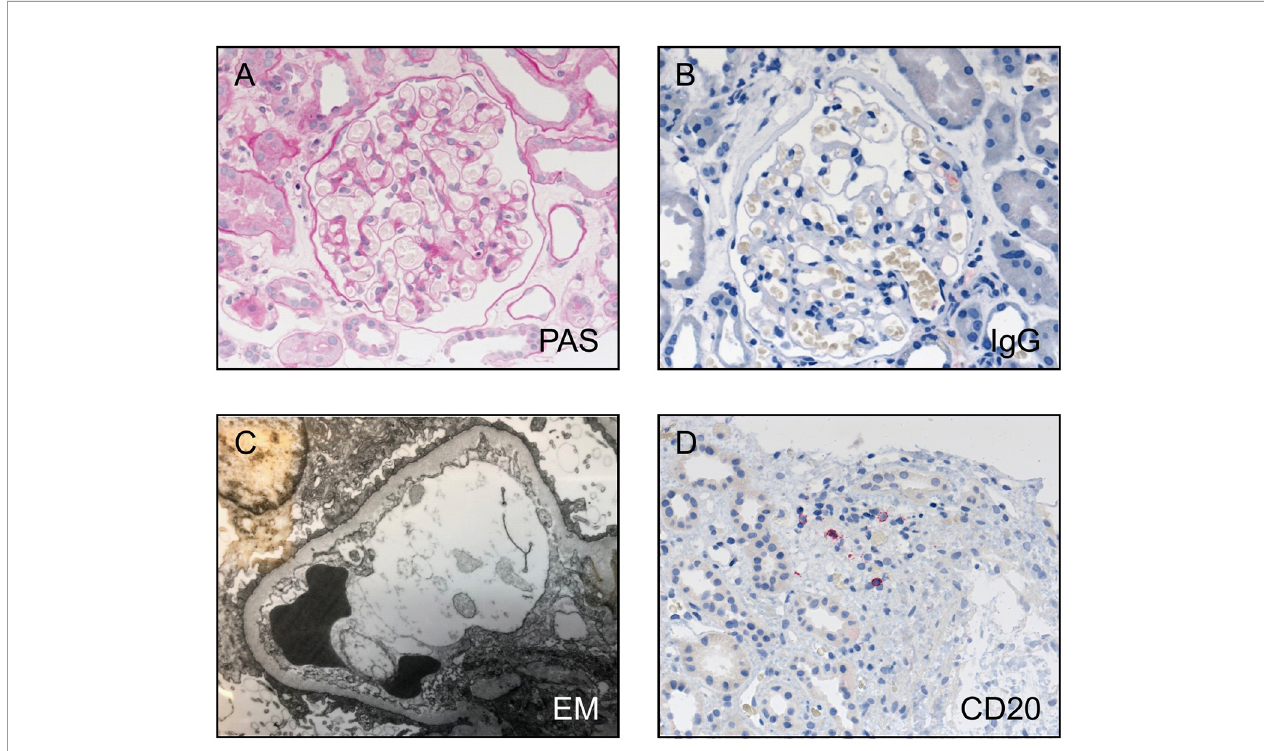
FIGURE 1 | Histological fi ndings in the kidney biopsy of the patient. (A) PAS staining, (B) IgG staining, and (C) electron microscopy con fi rm the diagnosis of minimal change disease with no IgG positivity, no electron dense deposits, and diffuse loss of podocyte foot processes. (D) Only very few CD20 positive cells were detectable, mostly in the area of tubular atrophy and interstitial fi